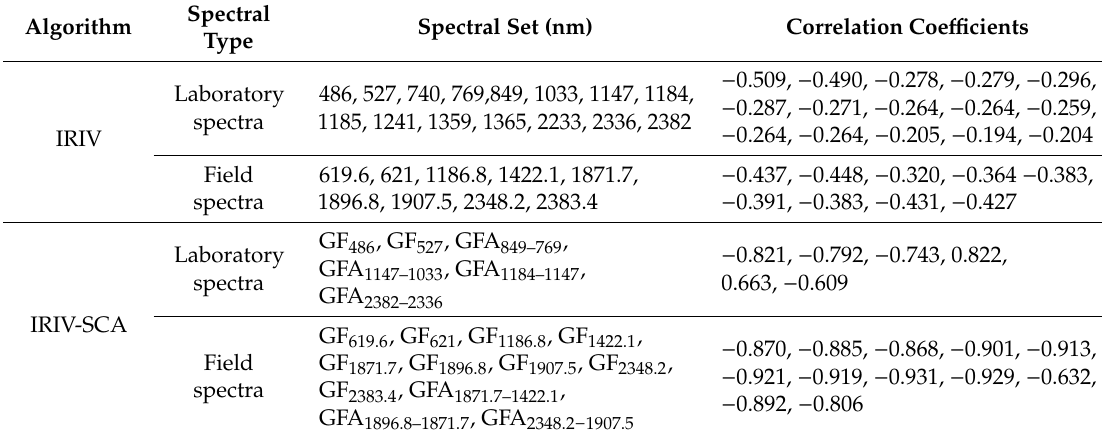
Table 3. The feature bands and the correlation coe ffi